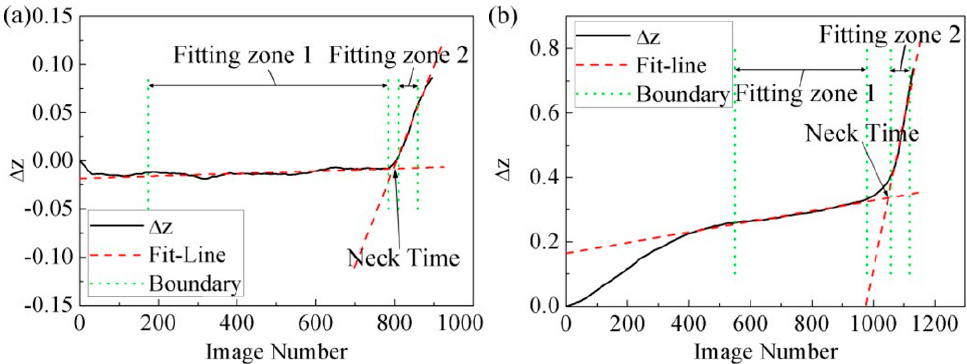
Figure 11. Variation tendency of ∆ z and necking time: ( a ) Uniaxial stretching strain region, ( b ) Biaxial stretching strain region.